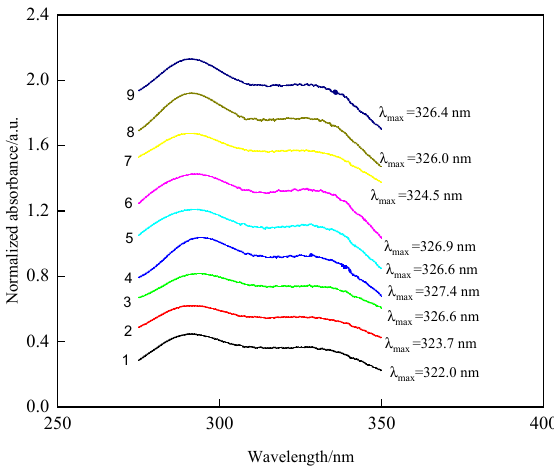
Figure 3. Normalized absorption spectra for the nine compounds in ethanol.